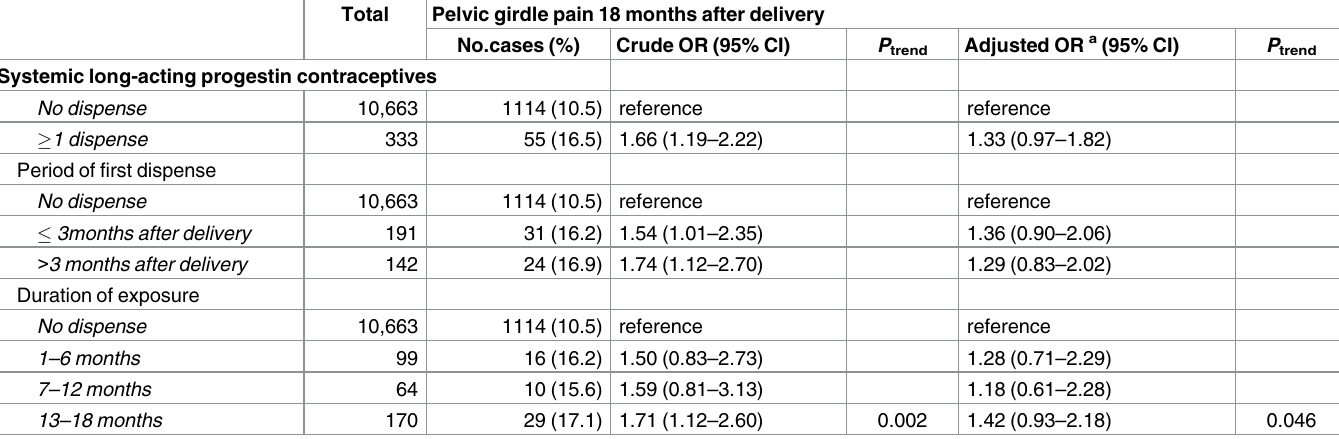
Table 5. Associations of systemic long-acting progestin contraceptives and pelvic girdle pain 18 months after delivery (N =